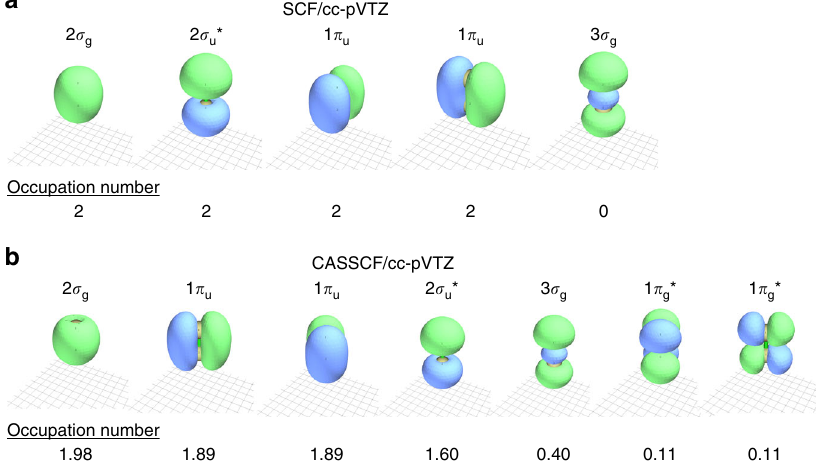
Fig. 2 Valence molecular orbitals of C 2 calculated using NWChem software 29 . a Orbitals calculated using an SCF (self-consistent fi eld) approach, recreating the molecular orbital diagram in Fig. 1b. b Orbitals calculated using a multicon fi gurational CASSCF (complete active space self-consistent fi eld) approach, which agree with the valance bond orbital diagram (Fig. 1c). Orbital occupation numbers are also given